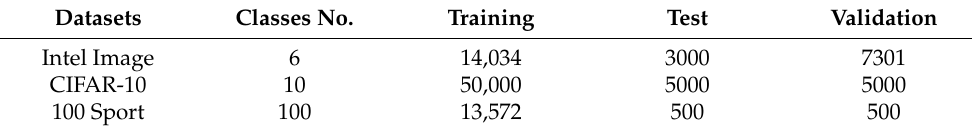
Figure 7. Noisy random predicted images with their labels predicted by our proposed model. Table 1. Details of the utilized datasets in six different models.